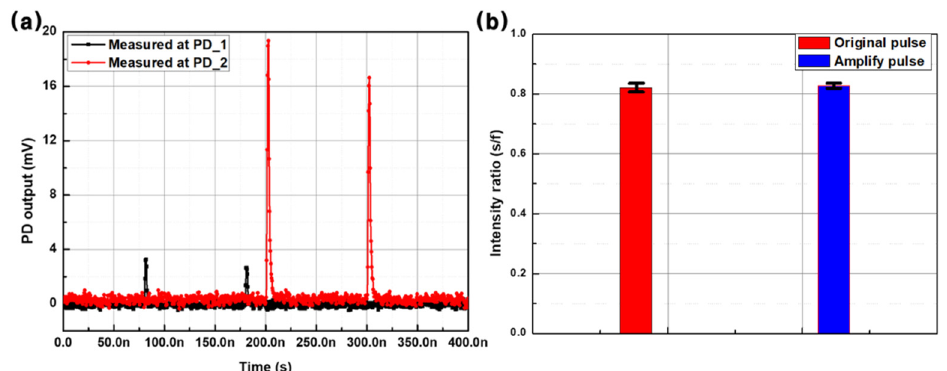
Figure 3. Double amplification method results: ( a ) intensity of the source and amplification pulses of |𝑓⟩ and |𝑠⟩ , ( b ) comparison of |𝑠⟩/|𝑓⟩ values of original pulse and amplitude pulse.